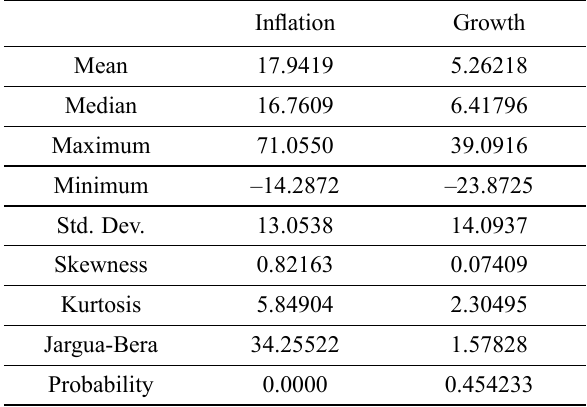
Table 1. Summary Statistics for Iranian Inflation and Growth